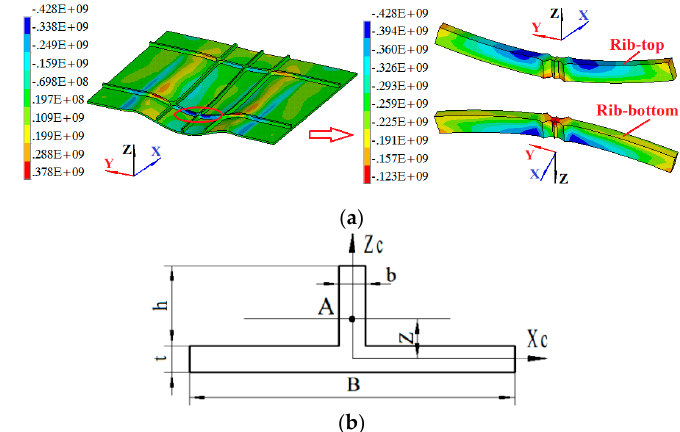
Figure 9. The Y -direction stress component (Pa) in the center of the Yf rib ( a ) and the inverted T-structure ( b